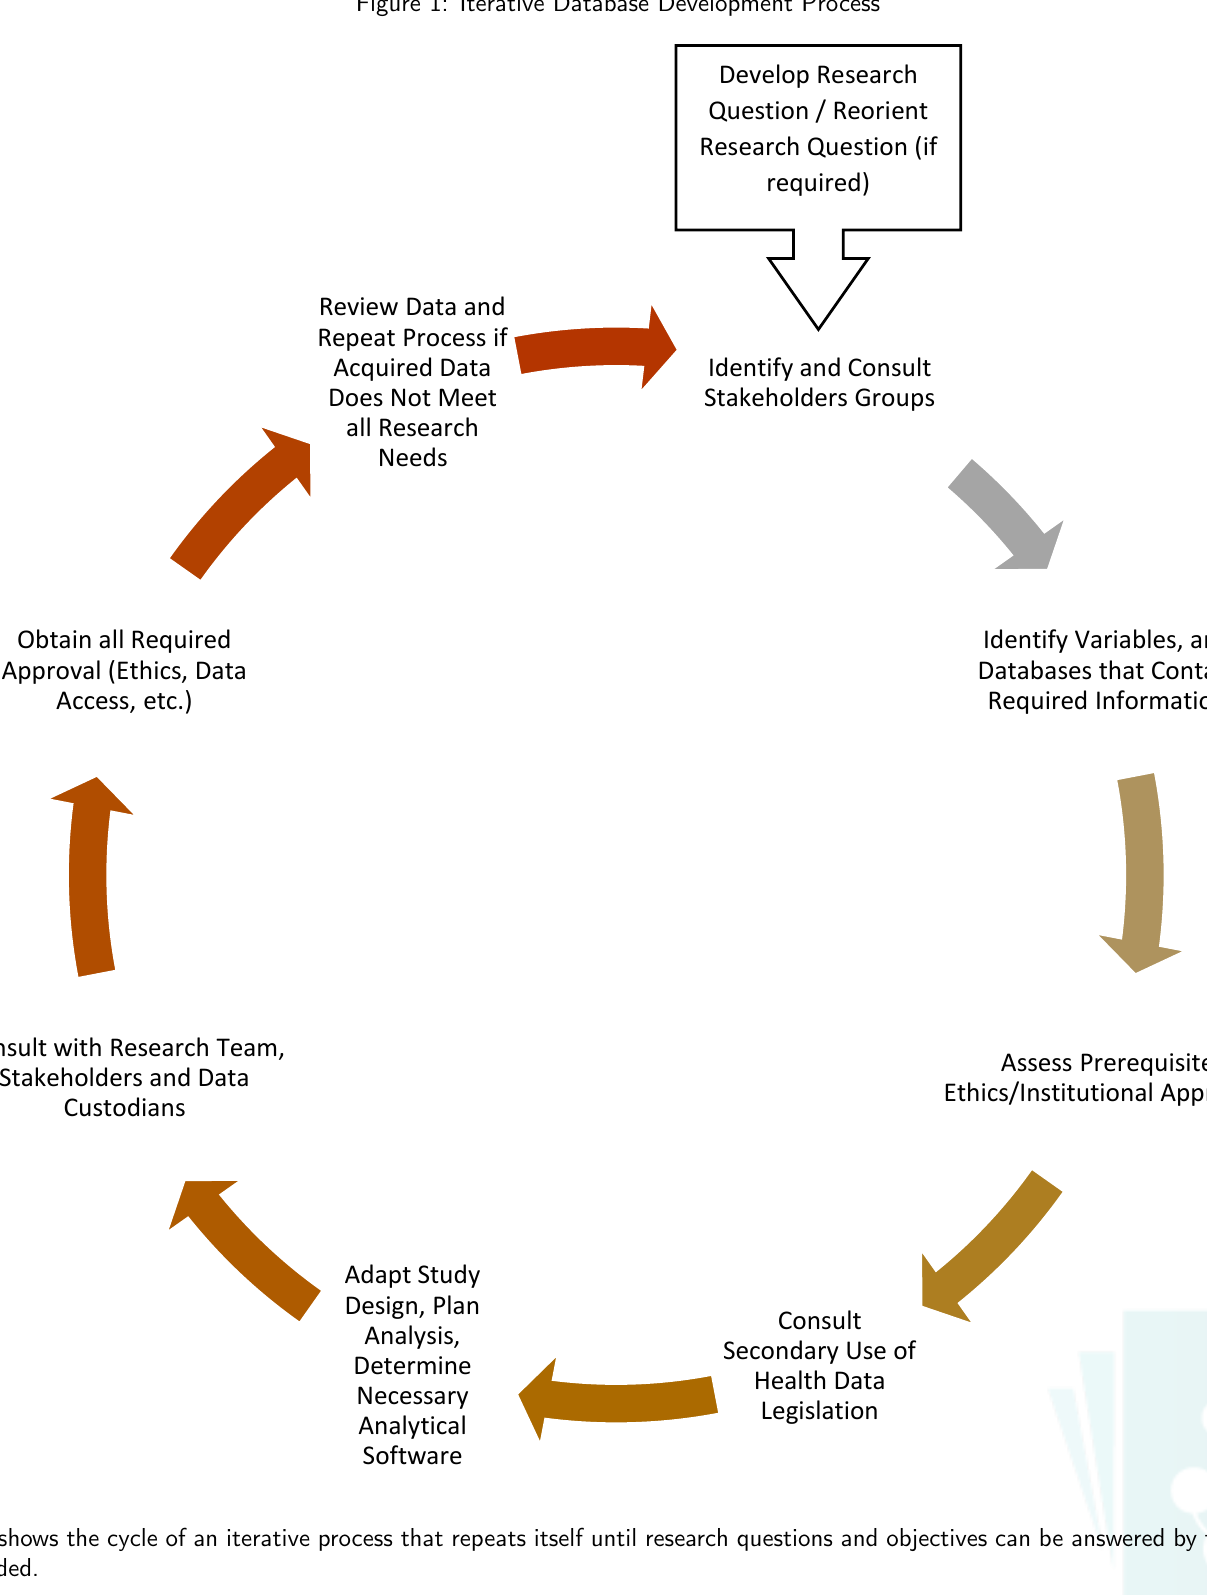
Figure 1: Iterative Database Development